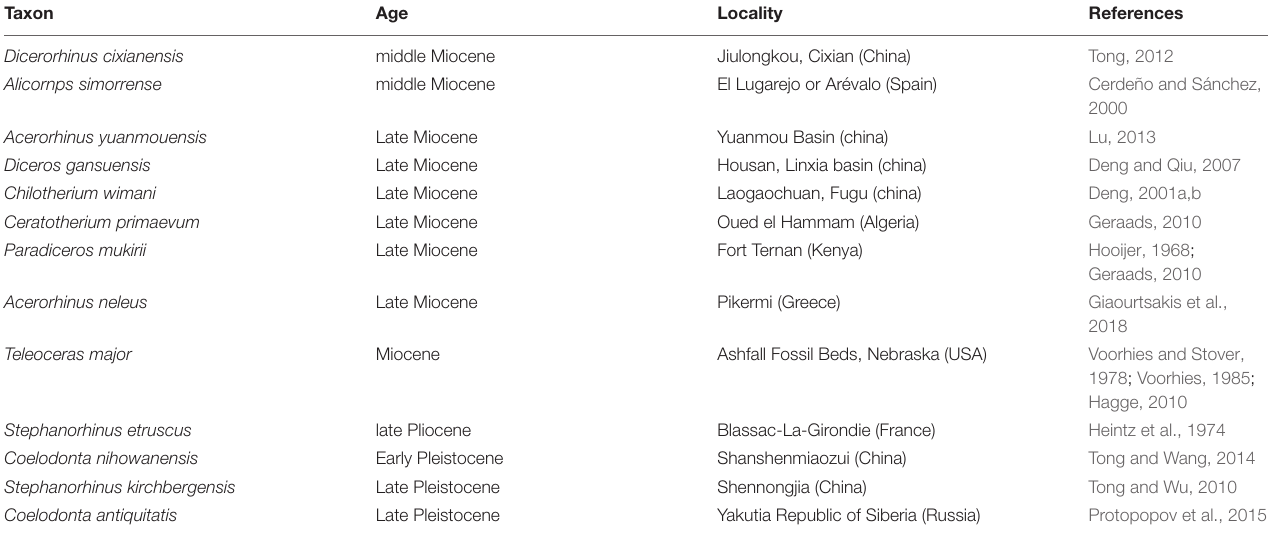
TABLE 1 | List of the fossil and extant specimens of juvenile Rhinocerotine considered from literature. Taxon